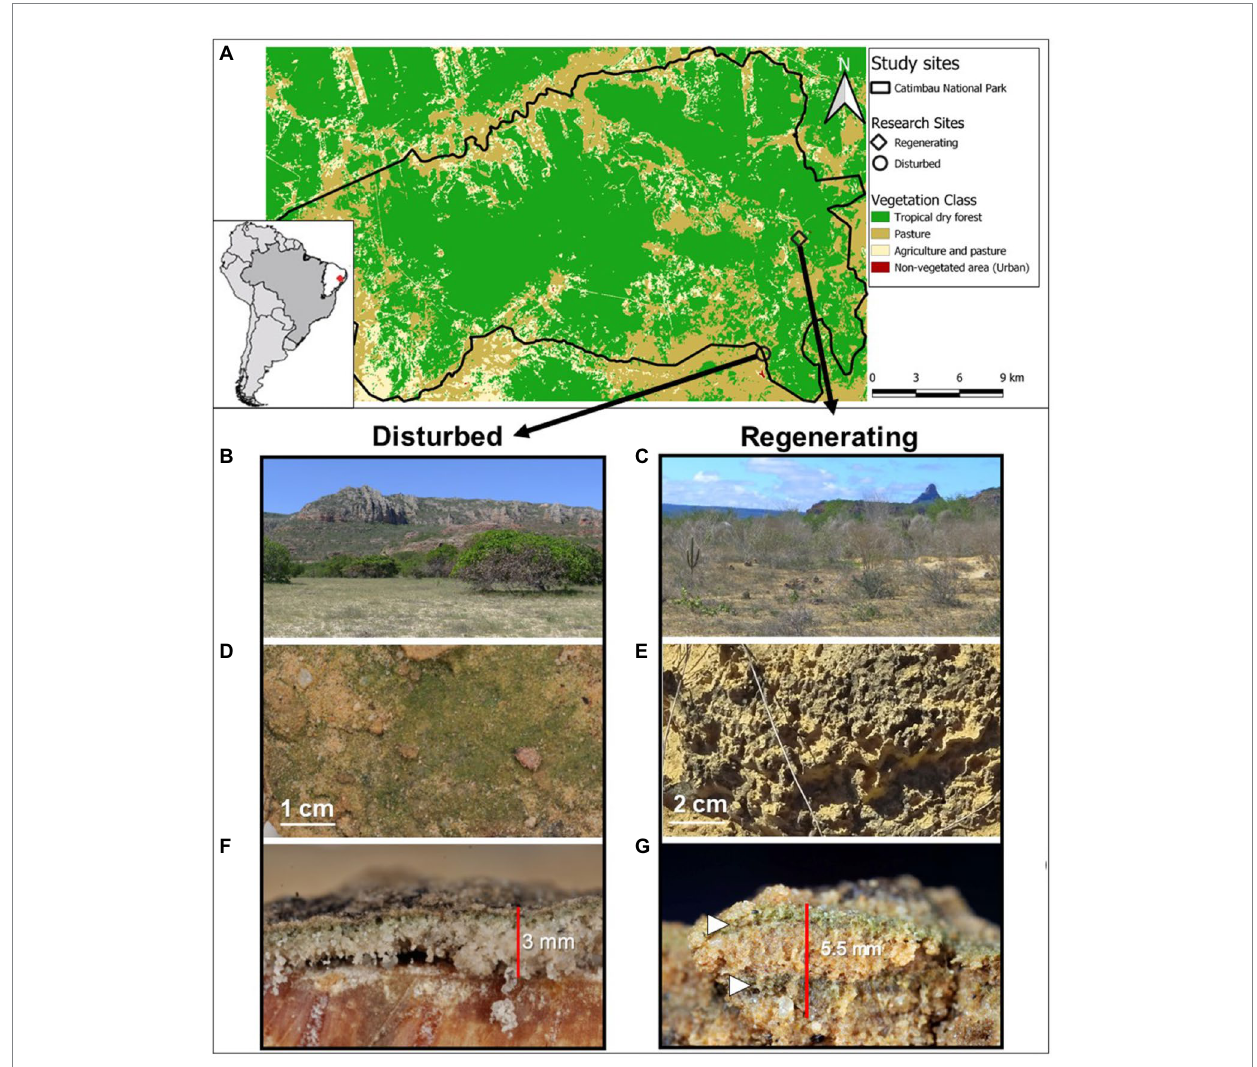
FIGURE 1 Case study sites within the Catimbau National Park, northeastern Brazil (A) including their associated biocrust communities. Overview of the two study sites at the very end of the dry season, an actively disturbed cashew plantation (B) and an abandoned, regenerating farm (C) . Closeups of the cyanobacteria-dominated biocrusts with a smooth (D) and a pinnacled surface (E) . Vertical cut through both biocrusts depicting a thin biocrust layer in the disturbed site (F) and a thick, possibly double-layered biocrust (white arrows) on the regenerating site (G)